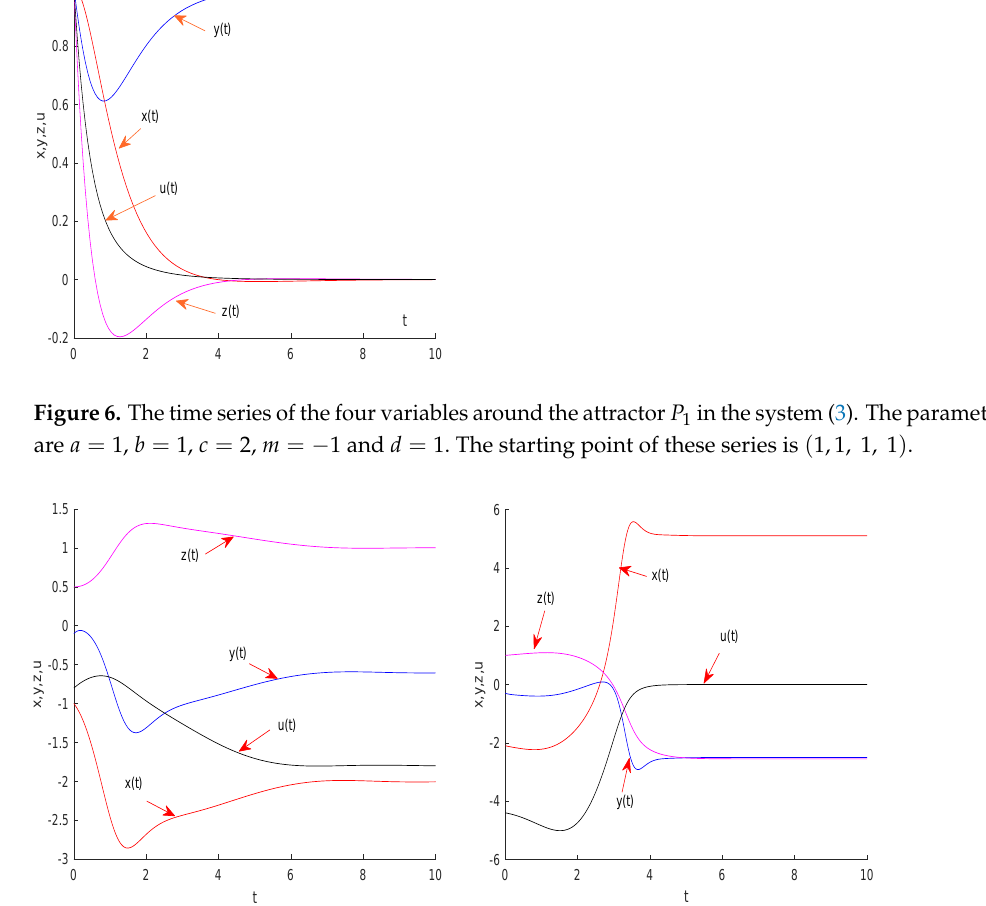
Figure 7. ( Left ). The time series of the four variables when P 4 is an attractor within the region R 8 . The parameters are a = − 2, b = 5, c = 2, m = − 1, d = 0.5 and P 4 ( − 2, − 0.6, 1, − 1.8 ) . The starting point of these series is ( − 1, − 0.1, − 0.5, − 0.8 ) . One may notice that the four series converge correspondingly to the four coordinates of P 4 as t increases, that is, x ( t ) → − 2, y ( t ) → − 0.6, z ( t ) → 1, and u ( t ) → − 1.8. ( Right ). The time series of the four variables when P 4 is a saddle within the region R 8 . The parameters are a = − 3, b = 10, c = 2, m = − 1, d = 0.5 and P 4 ( − 2, − 0.3, 1, − 4.4 ) . The starting point of these series is ( − 2.1, − 0.3, 1, − 4.4 ) . One may notice that the four series do not converge correspondingly to the four coordinates of P 4 as t